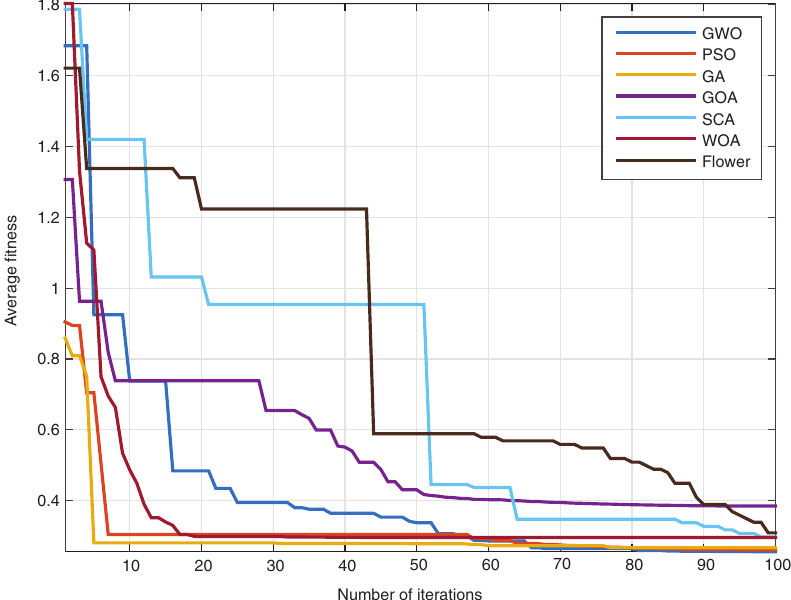
Figure 11: Convergence Curve of All Optimization